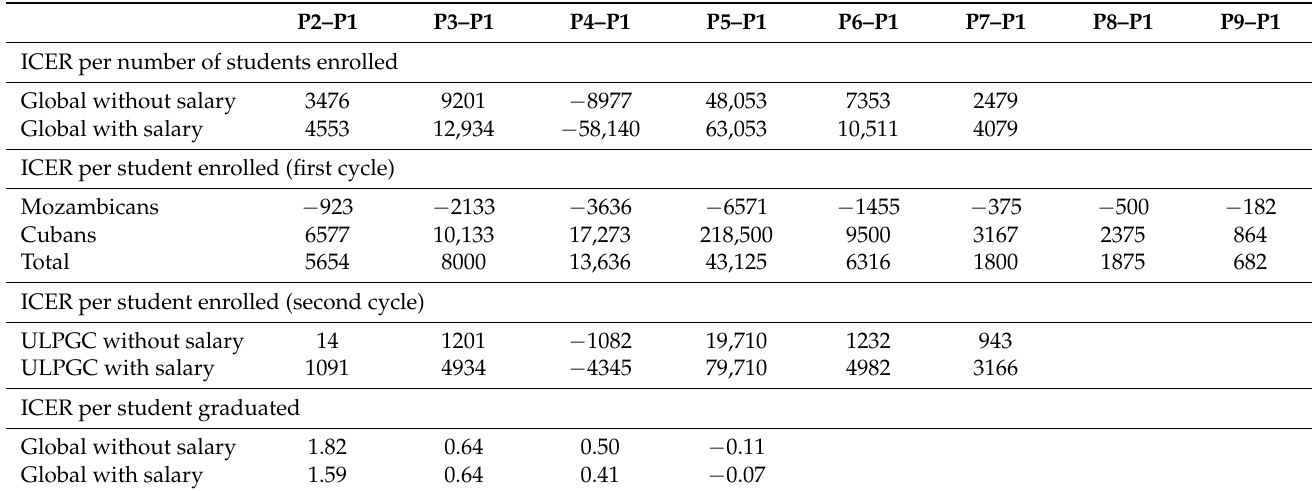
Table 2. Incremental cost-effectiveness ratio (ICER) per student enrolled in the first and second cycles using class of graduates one as the baseline. ULPGC, University of Las Palmas de Gran Canaria.